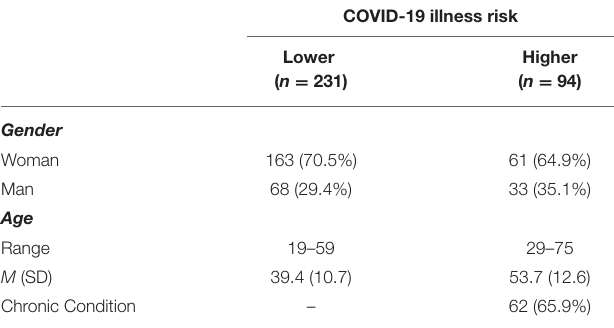
FIGURE 1 | Graphical representation of the COVID-19 pandemic in Spain. Dashed lines represent the period when the data of this study was collected. Figure slightly adapted from the Spanish Ministry of Health website. https://cnecovid.isciii.es/covid19/#ccaa. TABLE 1 | Demographics related to the COVID-19 illness